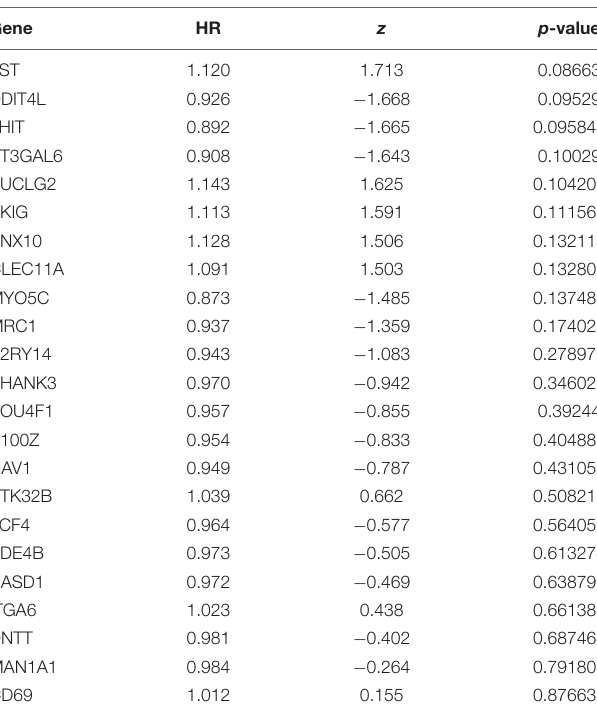
TABLE 3 | The result of univariate Cox regression in training